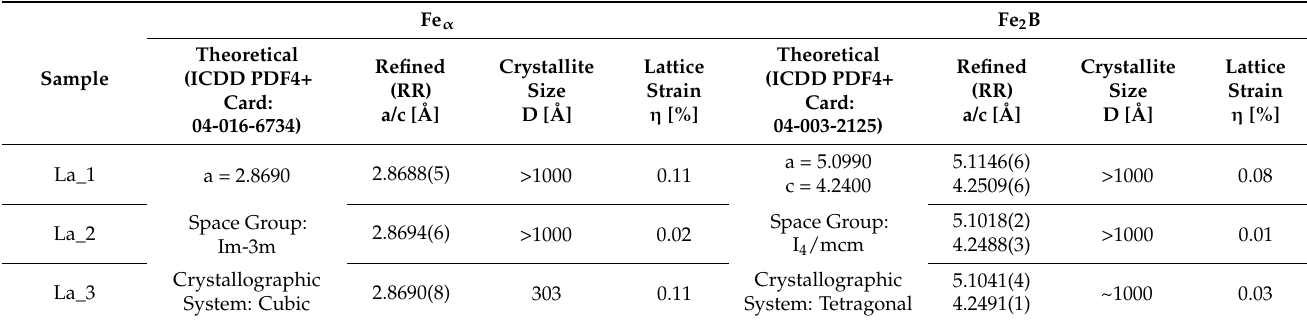
Table 3. Crystallite size and changes of unit cell parameters of the main phases present in tested Fe-B-La-Al ingots. Sample